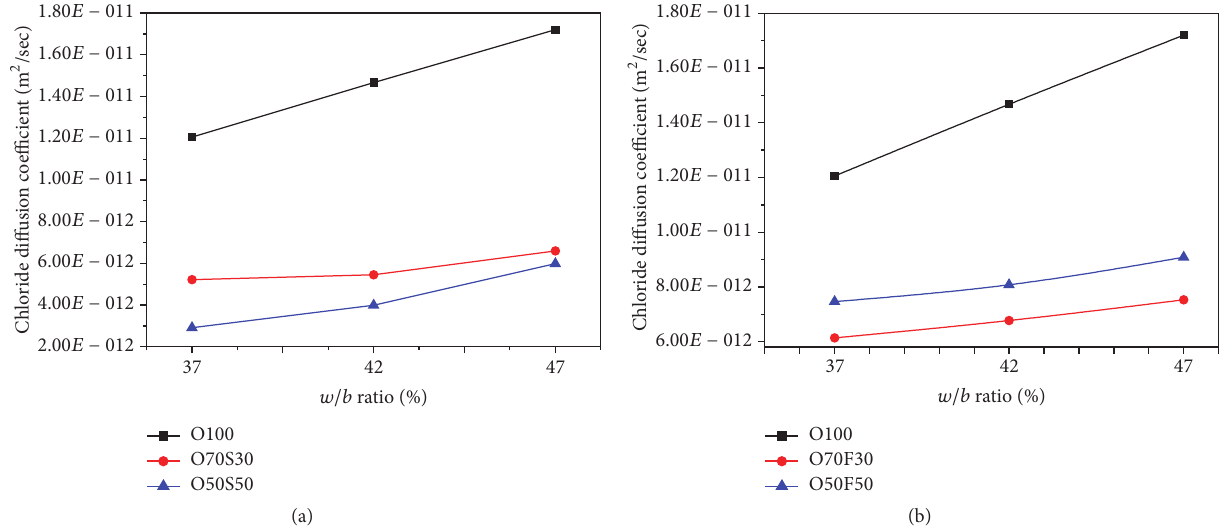
Figure 5: Chloride diffusion coefficient of HPC with (a) GGBFS and (b) FA at steady state